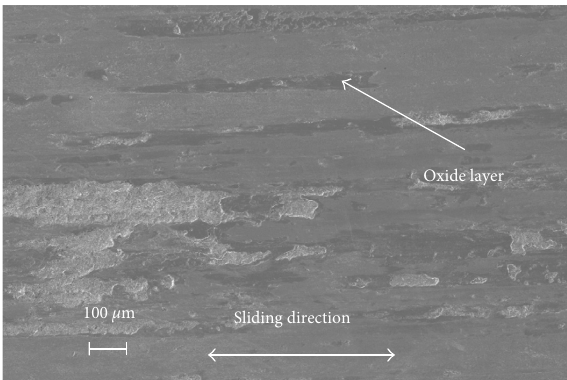
Figure 7: Scanning electron microscope micrograph of the steel 2 disk surface tested at 40 °